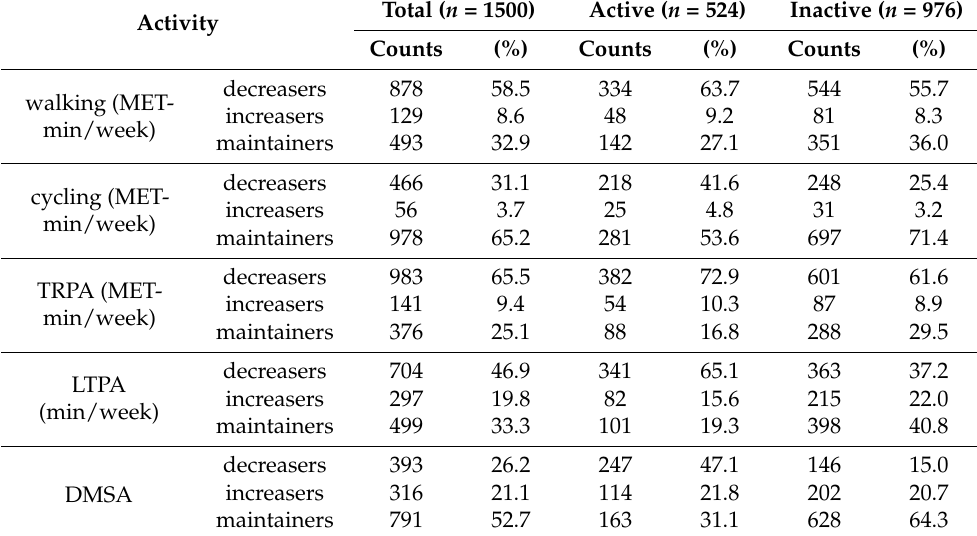
strengthening activities per week, METmin/week = metabolic equivalent of task minutes per week.